Question: Identify the chart type used in this figure.
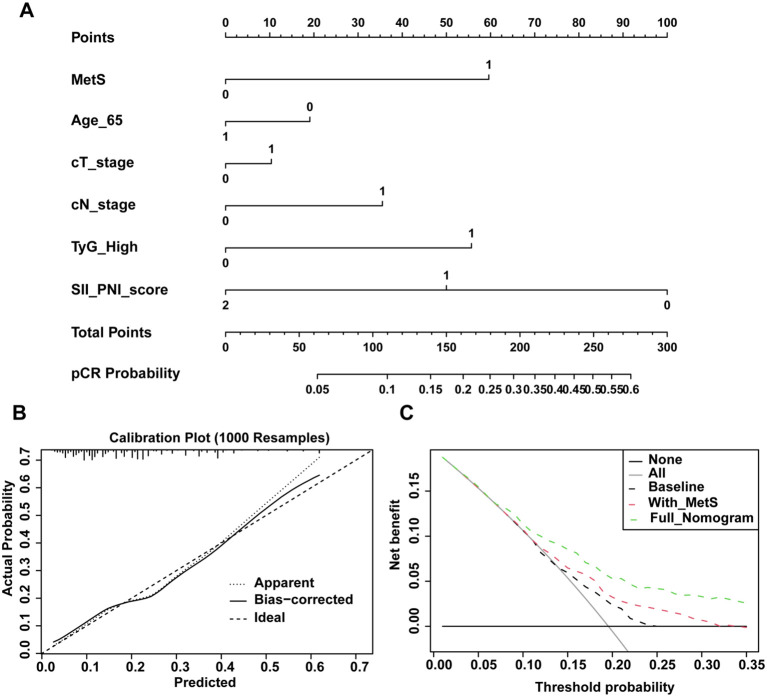
Answer: line